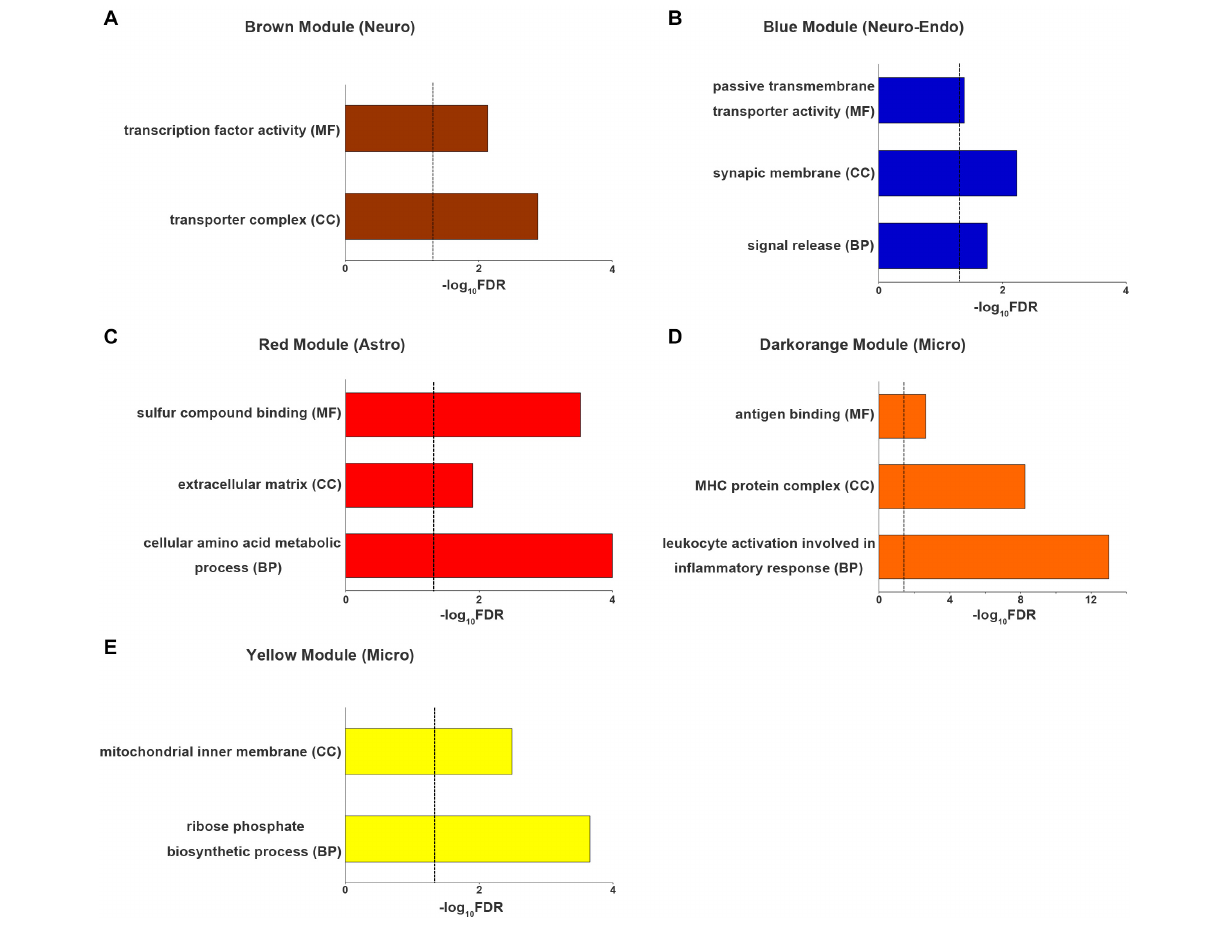
FIGURE 5 | The top enriched Gene Ontology terms for each cell-type-specific module. (A) neuron (brown) module, (B) neuron-endo (blue) module, (C) astrocyte (red) module and (D,E) microglia (darkorange and yellow) modules. The dashed line indicates the FDR-corrected threshold. Astro, astrocytoma; BP, biological process; CC, cellular component; Endo, endothelium; Micro, microglia; FDR, the corrected P values with the false discovery rate method; MF, molecular function; Neuro, neuron; Oligo,